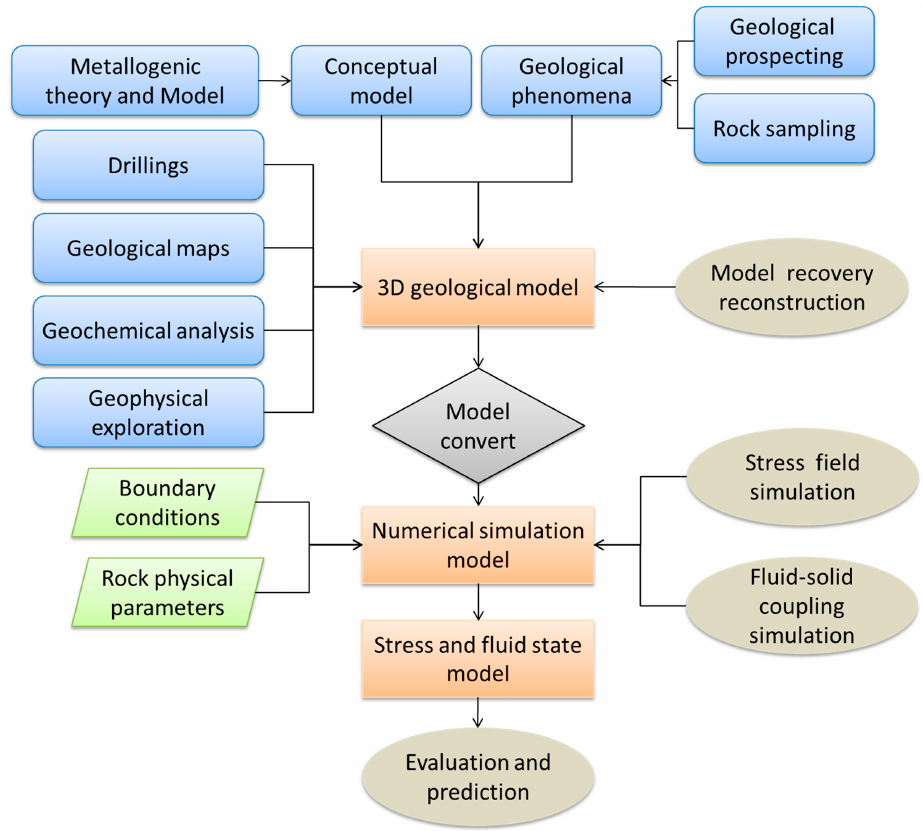
Figure 4. Numerical simulation